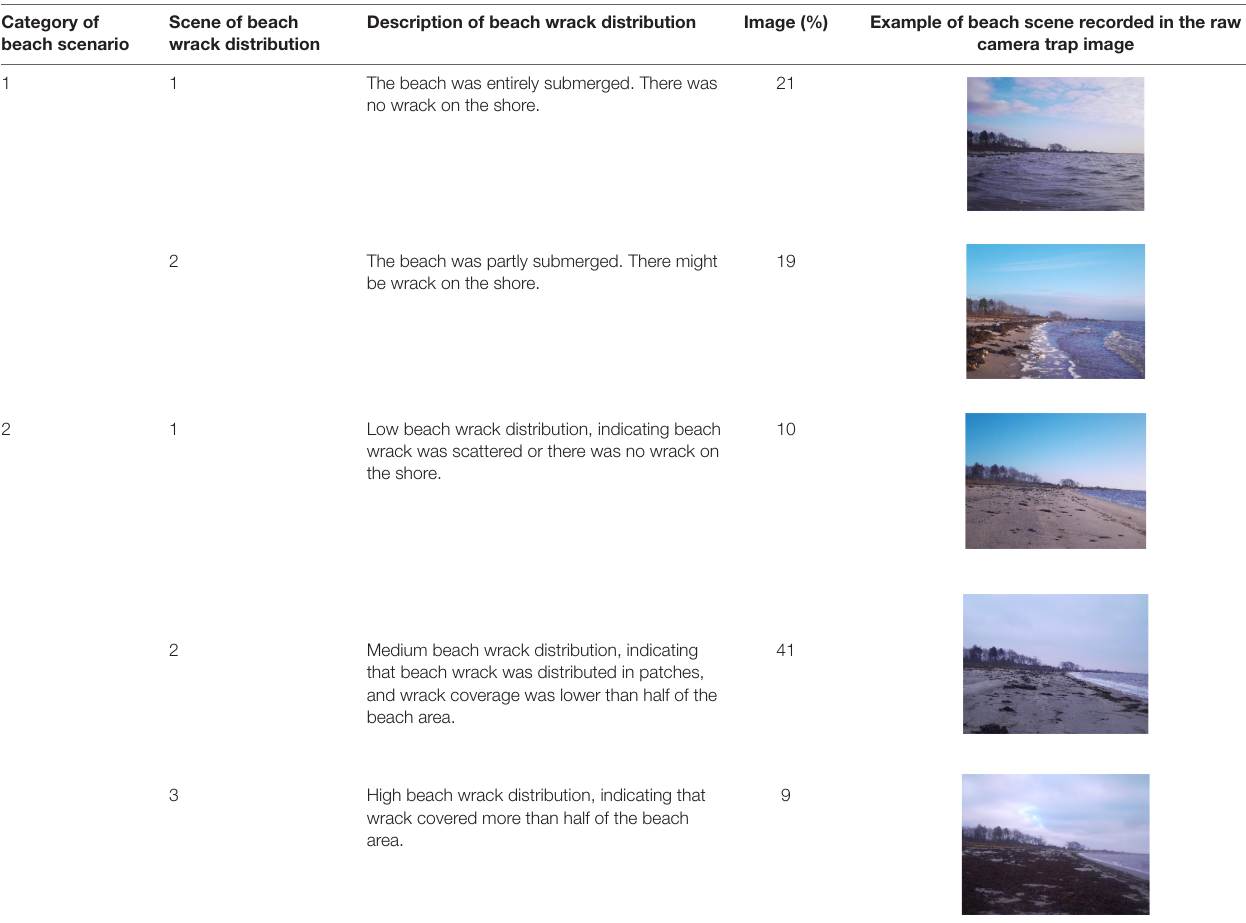
TABLE 1 | Beach scenarios and scenes of wrack distribution on the shore recorded in the camera trap images. Category of Scene of beach beach scenario wrack